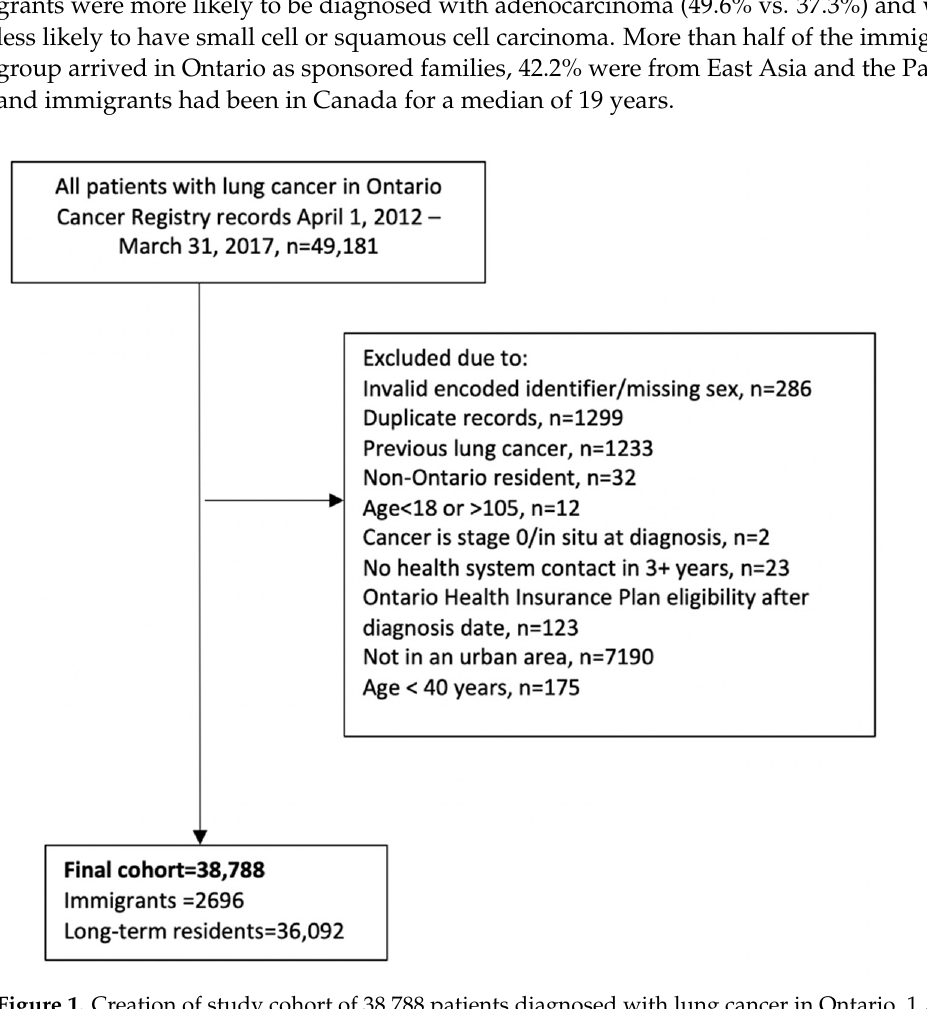
Table 1. Descriptive characteristics by immigrant status of 38,788 people in Ontario diagnosed with lung cancer, 1 April